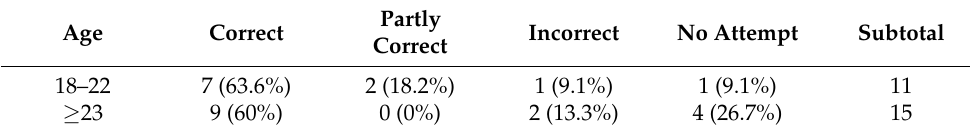
The percentage inside the parentheses is the relative value against the subtotal of an age group.